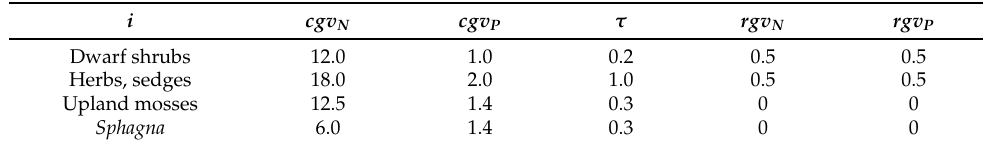
Table A2. Ground vegetation nutrient contents ( cgv N , P , mg g − 1 ), turnover time ( τ , years − 1 ), and nutrient retranslocation fractions ( rgv N , P , kg kg − 1